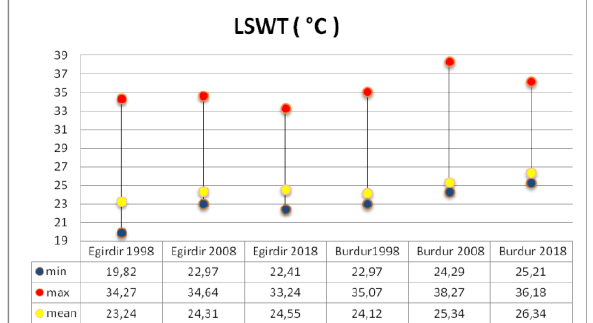
Figure 7 . Egirdir and Burdur lakes min-max and mean LSWT graphs for the years 1998, 2008 and 2018,